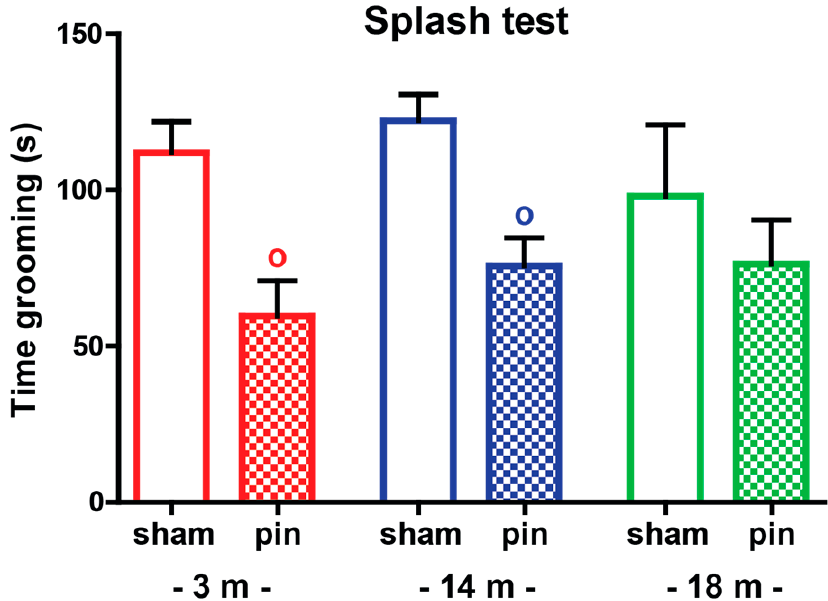
Figure 4. The effect of pin on grooming frequency of 3-, 14- and 18-month-old rats tested in the splash test. Data are presented as mean ± S.E.M. o p = 0.011, 3-month-old pin compared to matched sham group; o p = 0.023, 14-month-old pin compared to matched sham group. 3-month-old rats—red; 14-month-old rats—blue; 18-month-old rats—green. 2.2. The Effect of Melatonin Deficit on Oxidative Stress Markers in the Hippocampus of Young Adult, Mature and Old